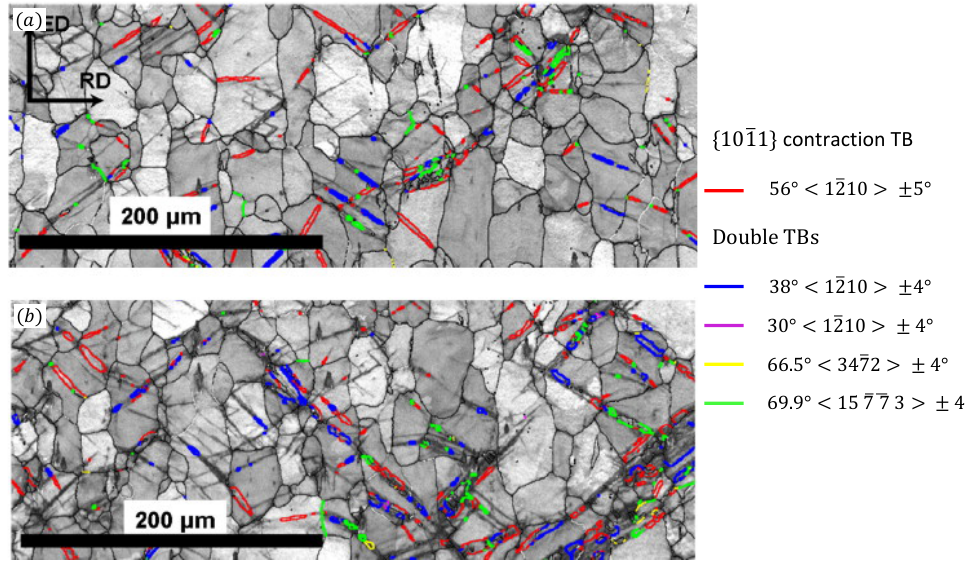
Figure 18. EBSD micrograph showing microstructure of Mg AM30 obtained after tensile strains of ( a ) 0.08 and ( b ) 0.15. Statistical analysis showed that secondary twin variants with misorientation of 38 ◦ and 69.9 ◦ are more preferred than others, reproduced from [223], with permission from Elsevier